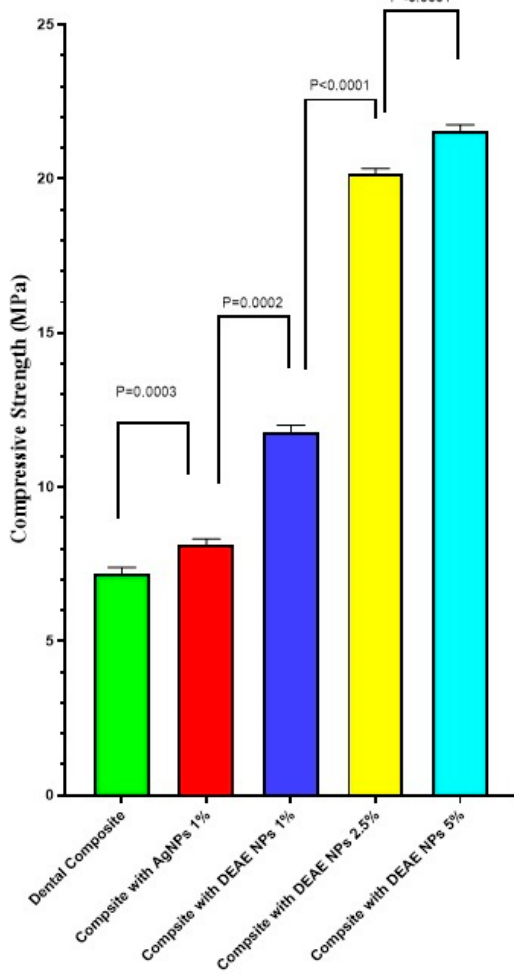
Figure 8. Compressive strength of modified and non-modified composite resins.